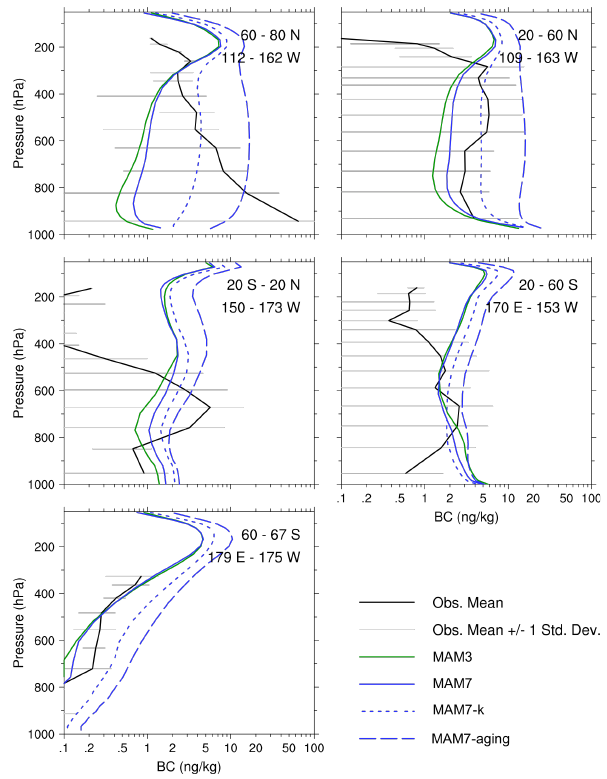
Figure 17. Same as Figure 16, but for BC vertical profiles above W. Canada, Alaska, the Fig. 17. Same as Fig. 16, but for BC vertical profiles above Arctic Ocean, and the remote Pacific Ocean during the HIAPER Pole-to-Pole W. Canada, Alaska, the Arctic Ocean, and the remote Pacific Ocean Observations (HIPPO) campaign in January 2009 (Schwarz et al., 2010). The